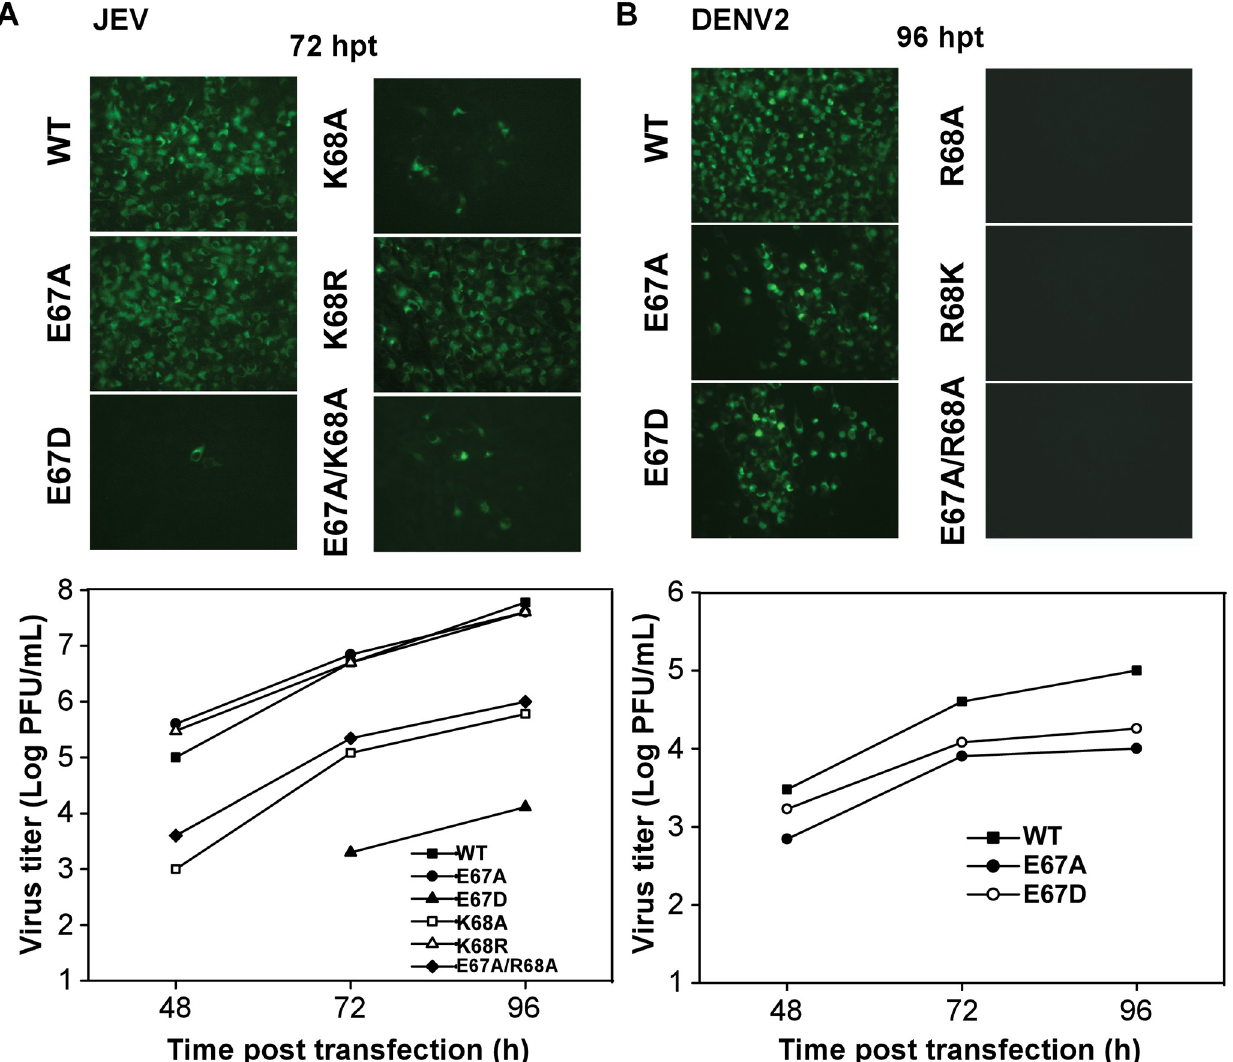
Fig 4. Virus proliferation analyses of the WT JEV and DENV2 and the viruses bearing the DENV3-mode mutations. A) Effects of NS5 mutations on JEV replication. IFA of JEV genome-length viral RNA containing E67A, E67D, K68A, K68R, and E67A/K68A mutations in transfected BHK-21 cells at 72 hpt. Monoclonal antibody 4G2 against envelope protein and FITC-conjugated goat anti-mouse IgG were used as primary and secondary antibodies for IFA, respectively. B) Effects of NS5 mutations on DENV2 replication. IFA of DENV2 genome-length viral RNA containing different mutations of NS5 in transfected BHK-21 cells at 96 hpt. Virus production of the supernatants of the transfected cells at each time point post transfection was detected by monolayer plaque assay, and the visible plaques were used to calculate titers.